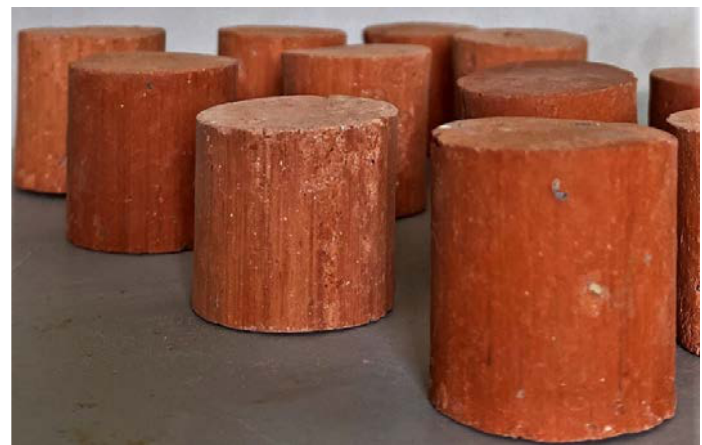
Fig. 1: Samples of fired test Fig.1: Samples of fired test bricks